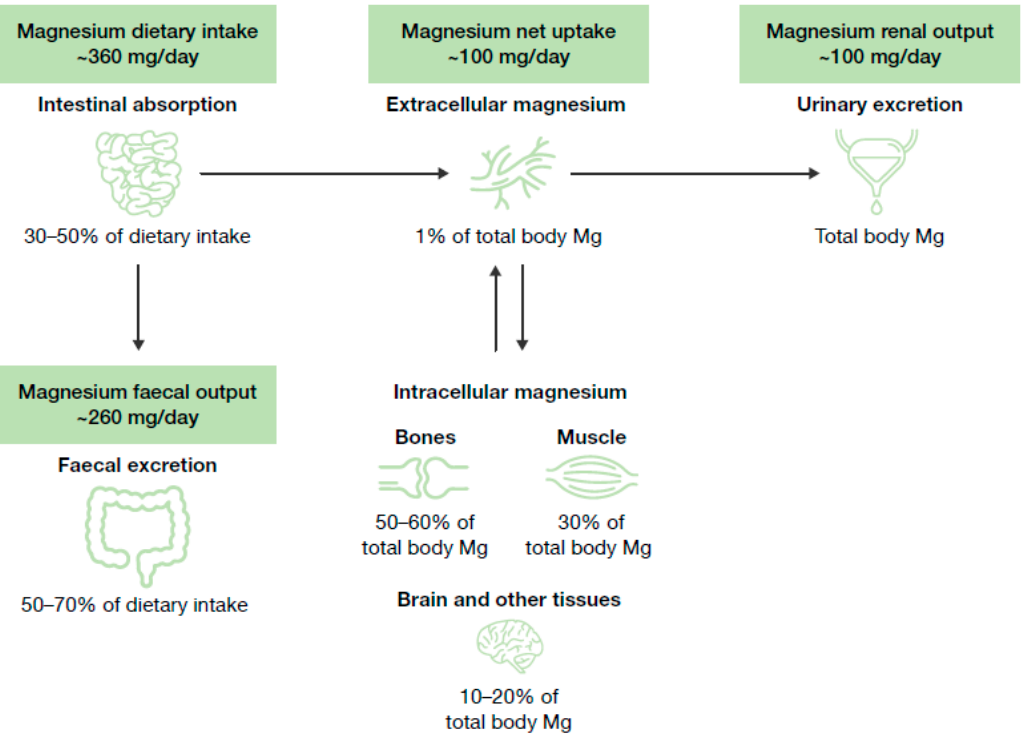
Figure 1. Magnesium homeostasis. Figure adapted from Jahnen–Dechent, 2012 [17]. Data from Elin, 1988 [19] and deBaaij, 2015 [8]. Mg, magnesium.